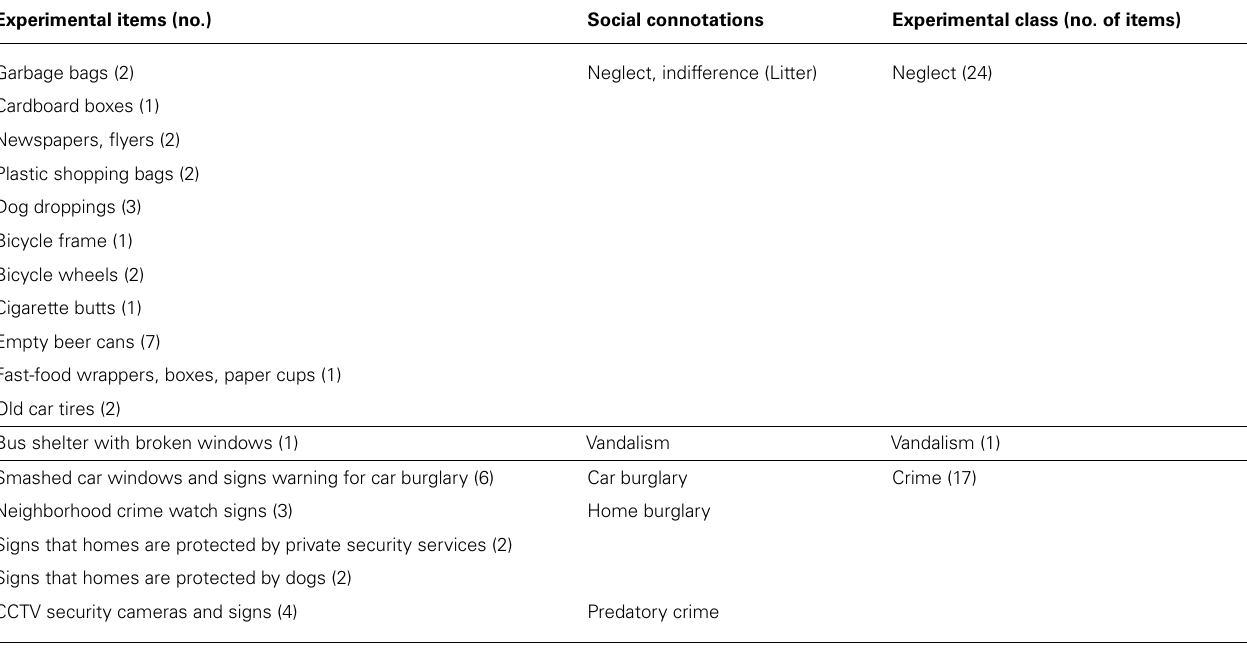
Table 1 | Experimental items, their connotations of physical and social disorder, and the experimental classification. Experimental items